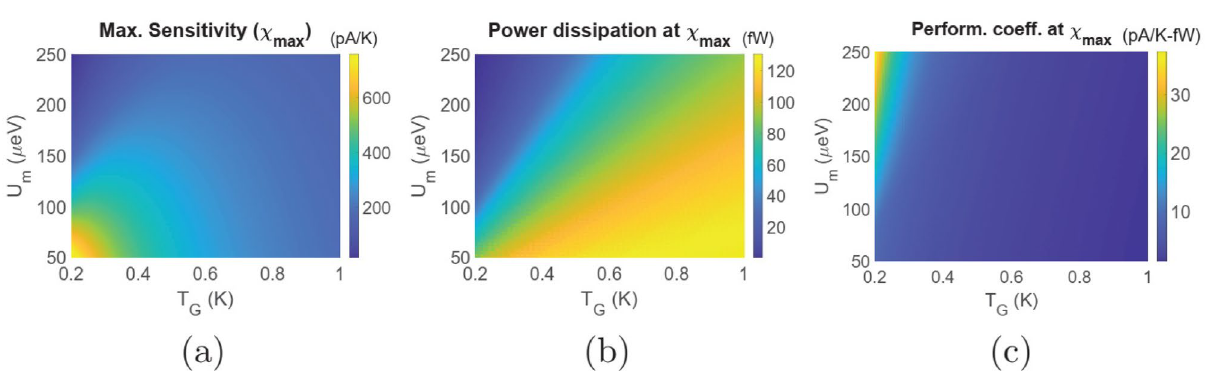
Figure 4. Regime of operation of the dual dot set-up in terms of the ground state energy positions relative to the equilibrium Fermi energy µ 0 . Colour plot demonstrating the variation in ( a ) sensitivity ( χ ) ( b ) power dissipation and ( c ) performance coefficient with variation in the ground state positions ξ 1 s and ξ g . The parameters used for simulation are U m = 100 µ eV, γ c = 10 µ eV, V = 1.1 mV and T L ( R ) = T G = 300 mK.